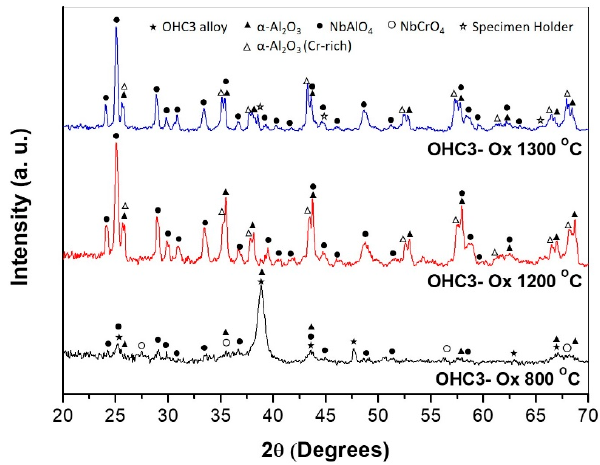
Figure 7. Glancing angle ( θ = 2°) X-ray diffraction (XRD) data of the scales formed in air at 800 °C, 1200 °C, and 1300 °C.